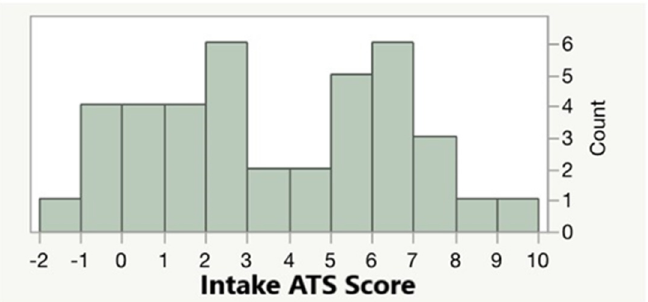
Figure 1. The distribution of ATS values at study intake. The distribution of the ATS in abstinent individuals is centered on zero, and scores above 4 are highly predictive of heavy alcohol consumption.